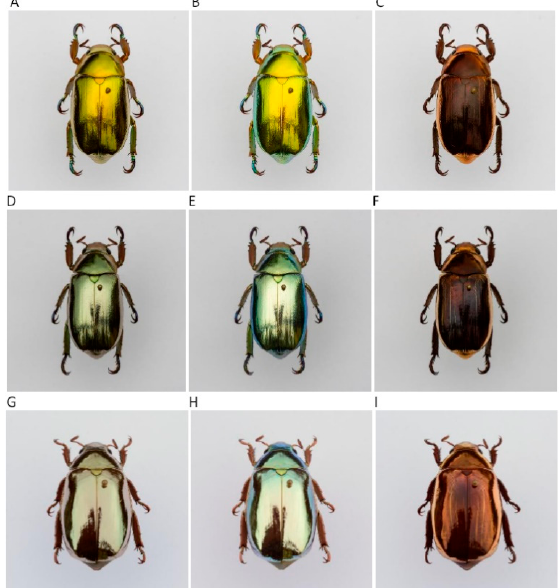
Figure 1. Appearance and circularly polarized light reflection from elytra of three jewel scarabs of the Chrysina genus. ( A – C ) Golden- and ( D – F ) silver-like C. chrysargyrea , and ( G – I ) silver-like C. optima specimens. The visual appearance of ( A ) golden C. chrysargyrea , ( D ) silvery C. chrysargyrea , and ( G ) silvery C. optima is shown on the left column. The middle column ( B , E , H ) shows photographs taken with a LHCP between the illuminated elytra and the objective of the camera. A RHCP was used for the photographs shown on the right column ( C , F , I